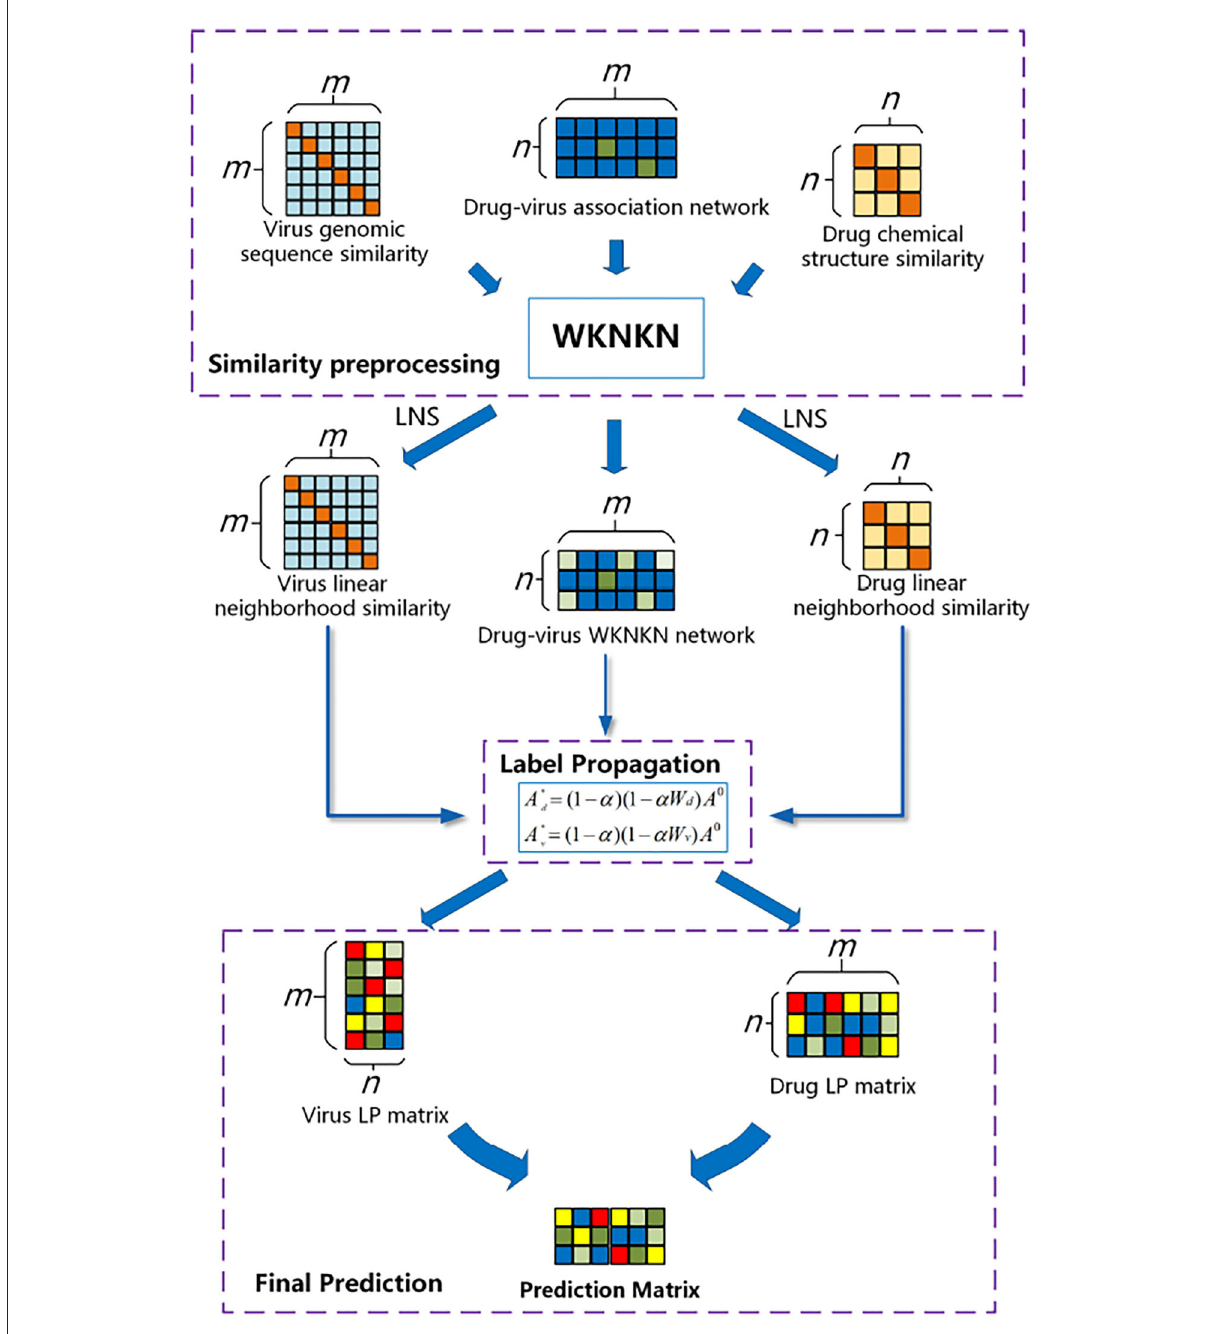
FIGURE1 Flowchart of the weighted reconstruction-based linear label propagation algorithm (WLLP) framework for drug–virus association